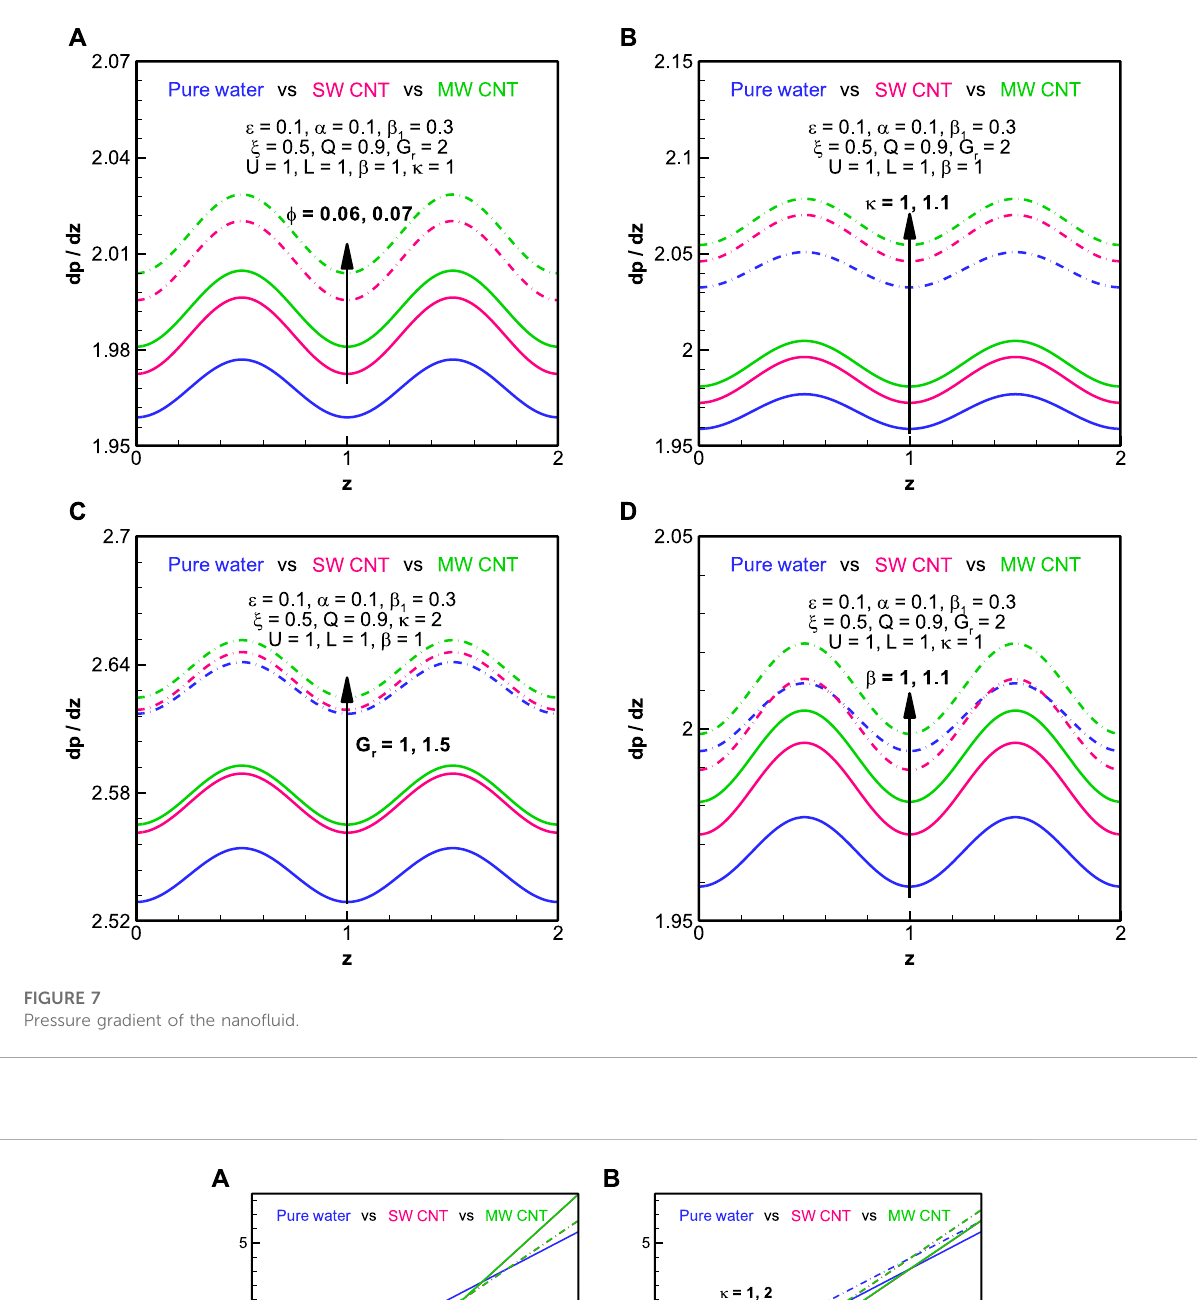
FIGURE 8 Pressure rise of the nano fl